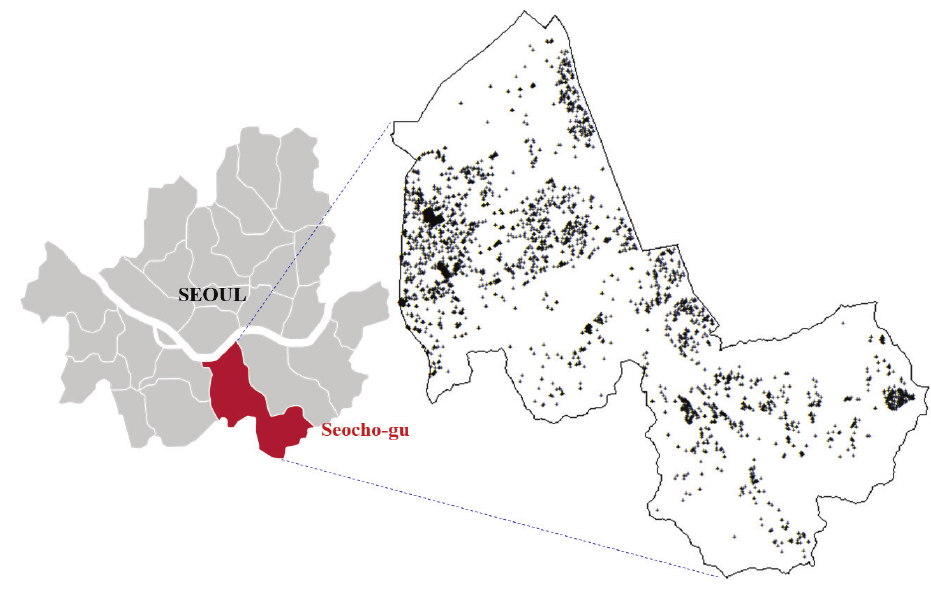
Figure 3. Locations of the 3,980 sites Table 2. Descriptive statistics of the 3,980 sites